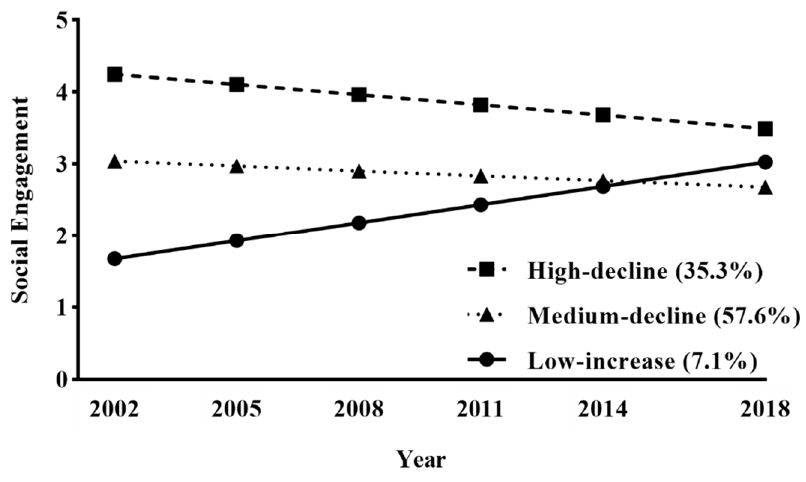
Figure 1. Heterogeneous trajectory classes of social engagement.